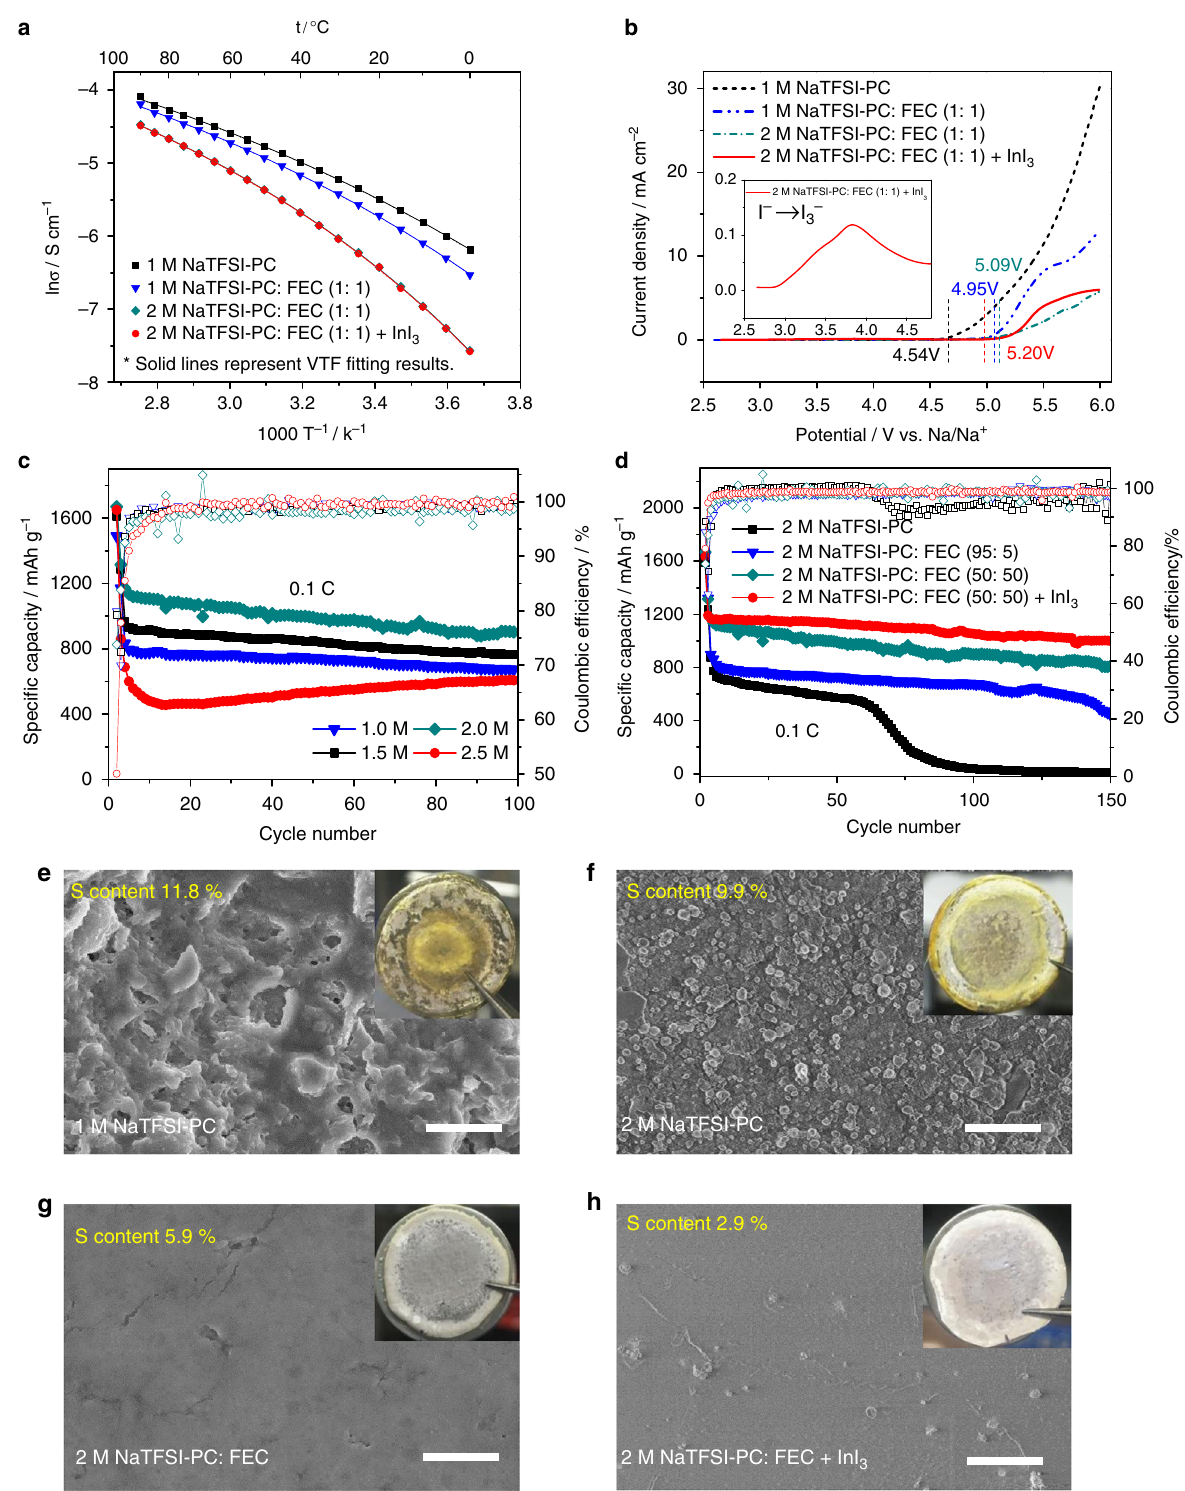
Fig. 2 Characterization of electrolytes. a Ionic conductivities of 1 M NaTFSI in PC, 1 M NaTFSI in PC: FEC (1:1 by volume), 2 M NaTFSI in PC: FEC (1:1 by volume) and 2 M NaTFSI in PC: FEC (1:1 by volume) with 10 mM InI 3 samples. The plots represent the experimental data while the solid lines represent VTF fi tting results. b LSVs of the above four electrolyte samples at a scan rate of 0.1 mV s − 1 using stainless steel as the working electrode, and Na as the counter and the reference electrodes. c Cycling performances of Na/S@MPCF cells using electrolytes with various concentration of NaTFSI in PC: FEC (1:1 by volume) solvents at 0.1 C, and d Na/S@MPCF cells containing 2 M NaTFSI in PC: FEC solvents with various FEC proportion and with/without InI 3 additive at 0.1 C. The corresponding Coulombic ef fi ciency represented by hollow symbols. e – h The FE-SEM images and optical images (shown in inset) of Na anodes obtained from Na/S@MPCF cells using different electrolytes after 50 cycles at 0.1 C. Scale bars are 2 μ m in Fig. 2e –